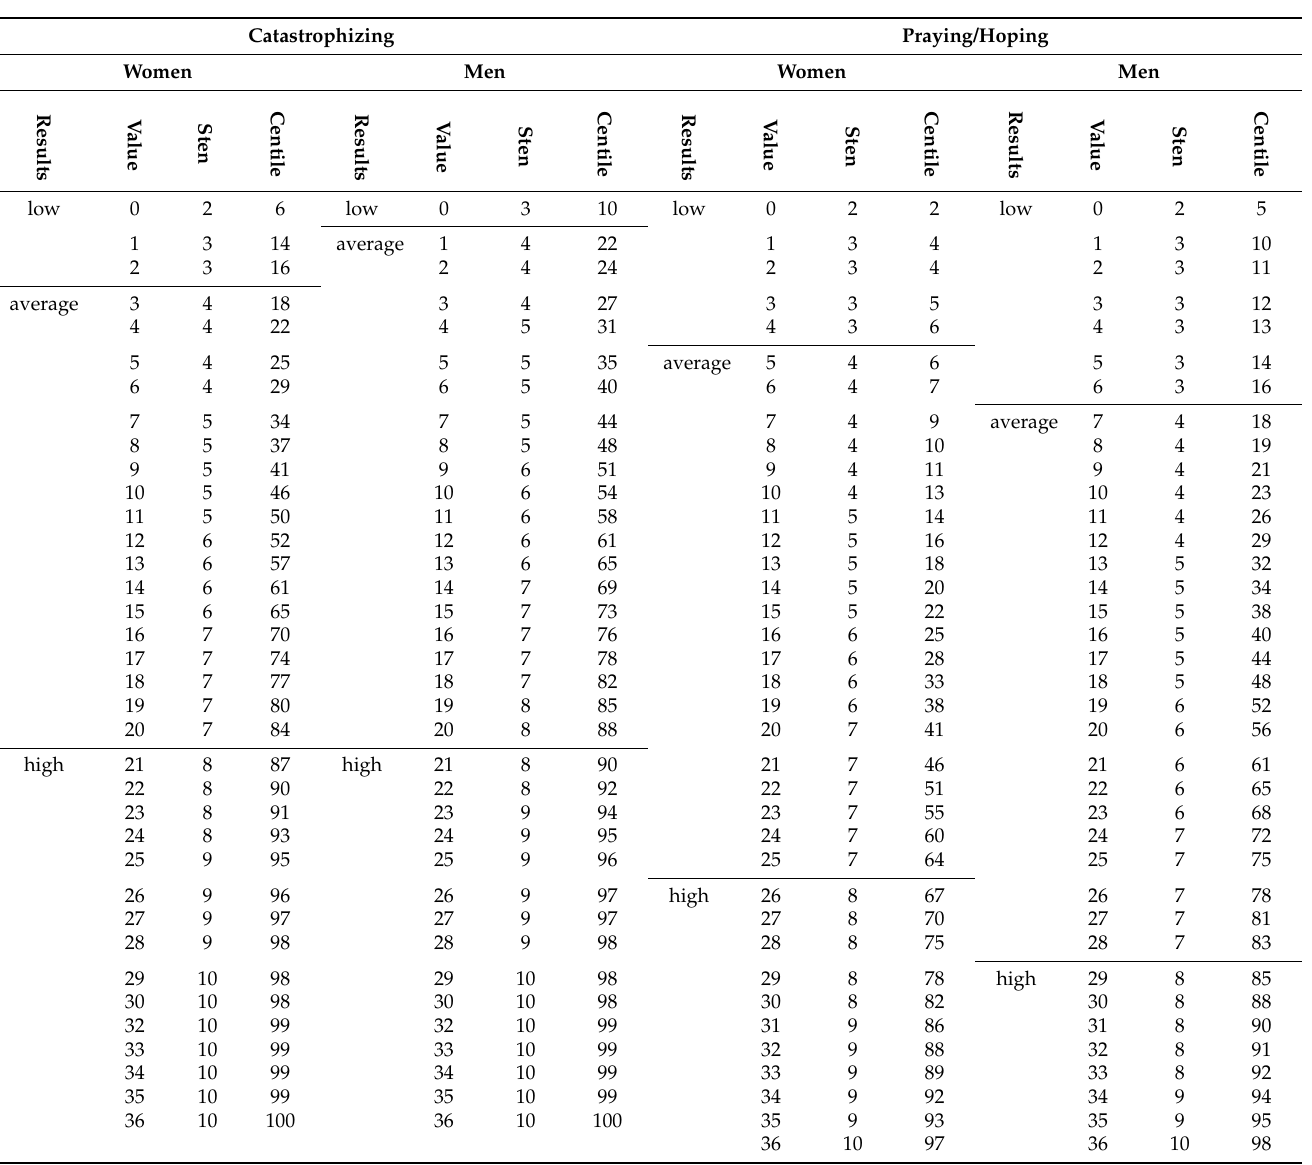
Table 6. Raw results and corresponding normalized results for catastrophizing and praying/hoping in groups of men and